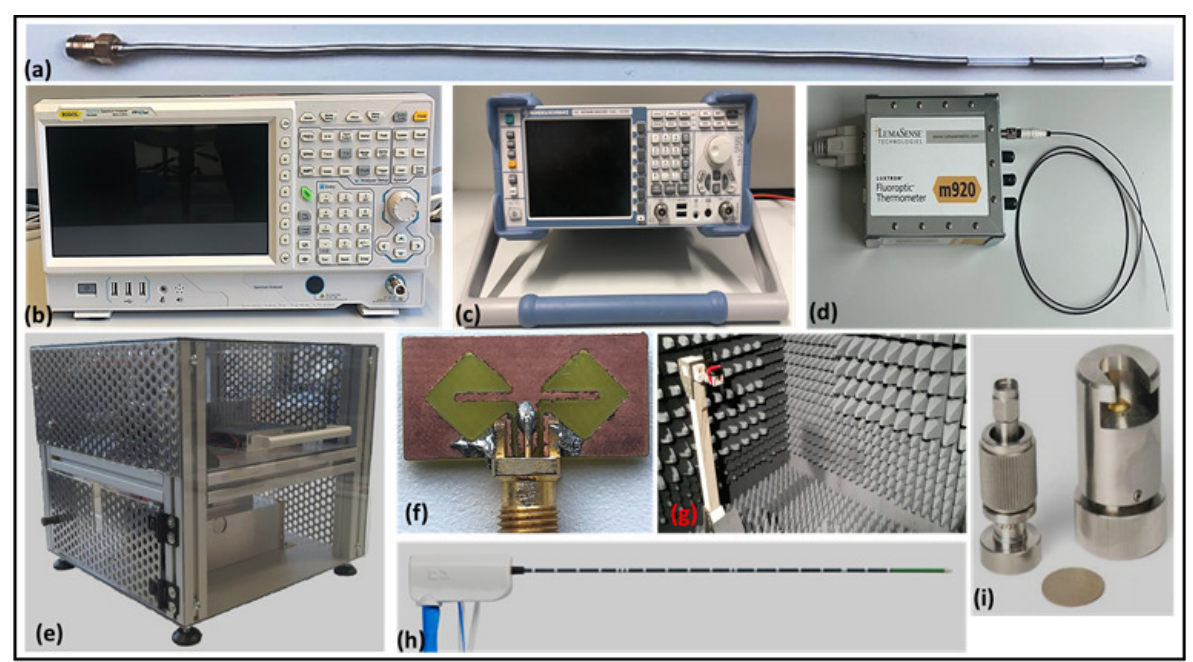
Figure 2. MWA experimental setup: ( a ) self-developed microwave applicator with a single slot; ( b ) spectrum analyzer; ( c ) VNA ; ( d ) LumaSense temperature probe; ( e ) high-power RF source; ( f ) BMA; ( g ) anechoic chamber; ( h ) Covidien